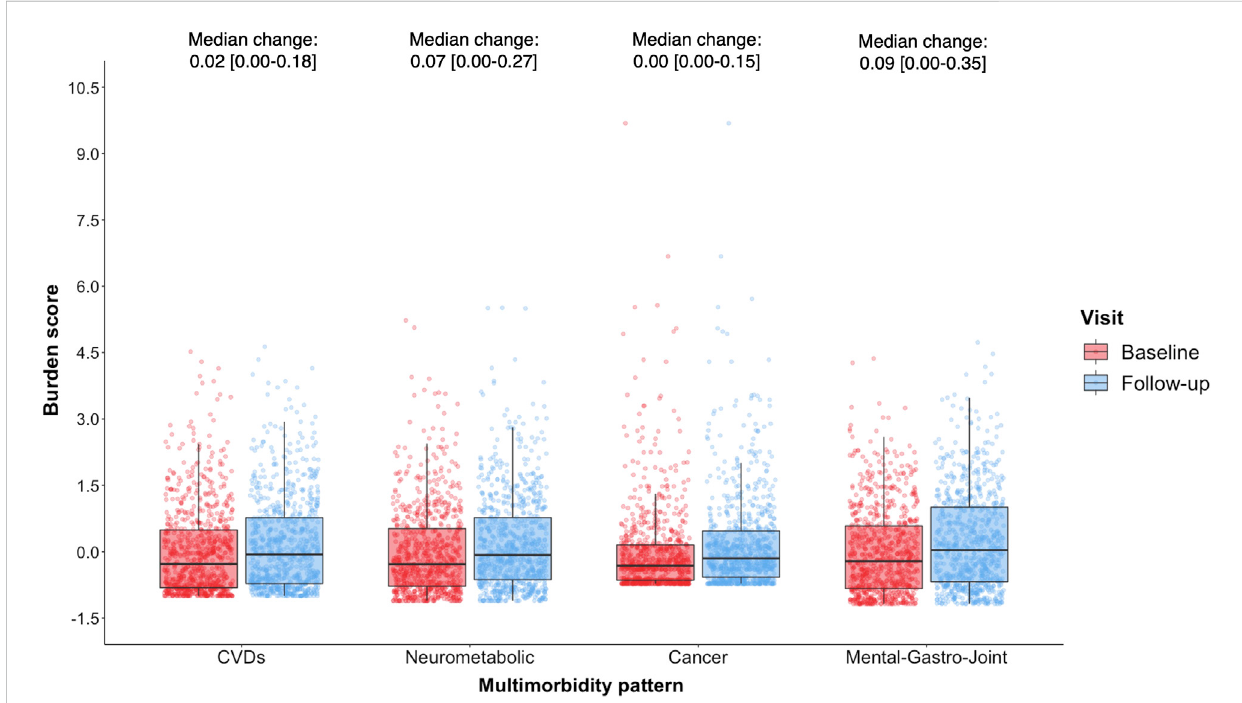
FIGURE 2 Distribution of multimorbidity burden z-scores at baseline (red) and follow-up (blue) among POPPY participants with HIV ( n = 788), with median change [interquartile range; IQR] also